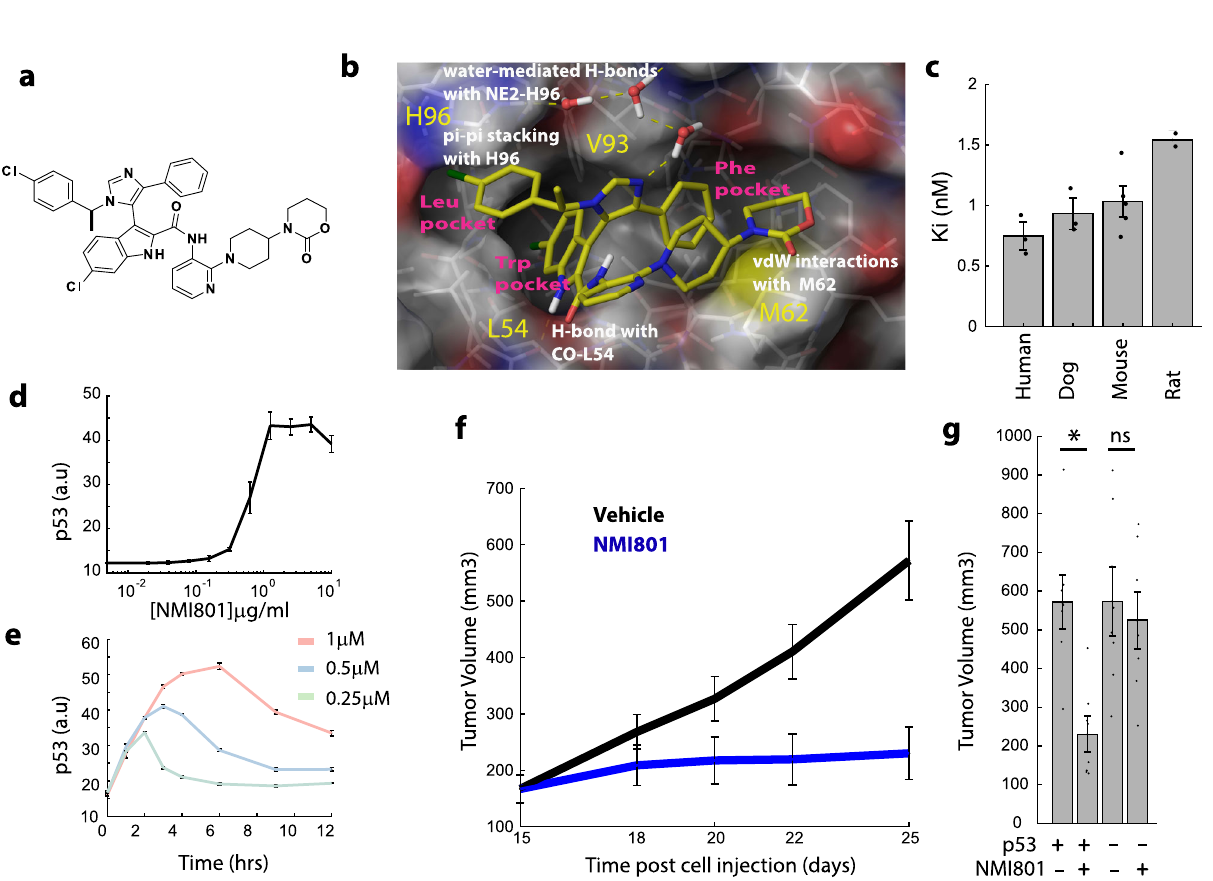
Fig. 3 A novel Mdm2 inhibitor, NMI801, ef fi ciently stabilizes p53 in mouse tissues and tumor xenograft models. a Chemical structure of NMI801. b X-ray structure of NMI801 bound to the p53-binding pocket of Mdm2, at 2.1 Å resolution. H-bonds are indicated by dashed lines. The Mdm2 sub-pockets binding the p53 residues Leu 26, Trp 23, and Phe 19 are labeled Leu- Trp- and Phe-pocket, respectively. The coordinates have been deposited in the PDB databank (PDB access code = 6I29). c Ki of NMI801 for inhibiting p53-Mdm2 complex formation from a FRET competition assay using Cy5 labeled p53 peptide and full length Mdm2 from Human, Dog, Rat, and Mouse ( n = 3 for human, dog; n = 5 for mouse; n = 2 for rat; error bars are SEM; points indicate individual measurements; mean is shown in bar plots). d Quanti fi cation of p53 levels by immuno fl uorescence in HEPA1C1C7 mouse cells 3 h after adding the indicated doses of NMI801 ( n = 4 imaging fi elds; error bars are SEM). e Quanti fi cation of p53 levels by immuno fl uorescence in HEPA1C1C7 mouse cells at the indicated times after adding 0.25, 0.5, or 1 μ M NMI801 ( n = 4 imaging fi elds; error bars are SEM). f , g Xenograft tumors of HCT116 were engrafted for 15 days to an average size of ~150 mm 3 . Mice were then treated with vehicle or NMI801 daily (200 mg/kg). f Tumor volume was measured at the indicated times after NMI801 treatment. g Final tumor volume in p53 wild-type or null mice treated with vehicle or NMI801 ( n = 8 mice/condition; error bars are SEM; dots indicate individual data points; *pval = 0.000356, two-sided t -test, no multiple comparison (Fig. 3f). Similar results were obtained with a second xenograft model of the human osteosarcoma cancer line SJSA-1 (Supple- mentary Fig. 5), suggesting the ef fi cacy of NMI801 in both epi- thelial- and mesenchymal-derived tumors. Xenografts of isogenic p53 null derivatives (HCT116 p53 − / − ) were unresponsive to NMI801, con fi rming the speci fi city of NMI801 for p53 (Fig. 3g). of the treated mice at doses suf fi cient to arrest tumor growth (Supplementary Fig. 6). Taken together these results con fi rm NMI801 as a potent Mdm2 inhibitor that stabilizes p53 in cells